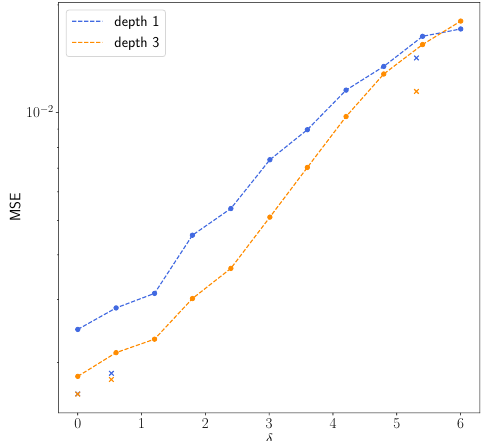
( 1 ) and ( 3 ) depend- R R